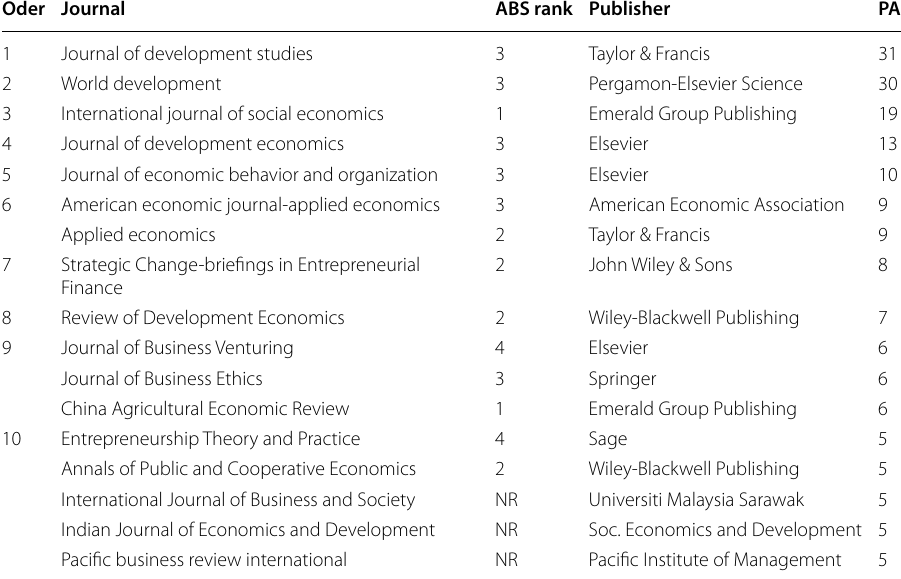
Table 3 Leading journals published between 01:2012 and 03:2021 on microfinance outcomes (demand